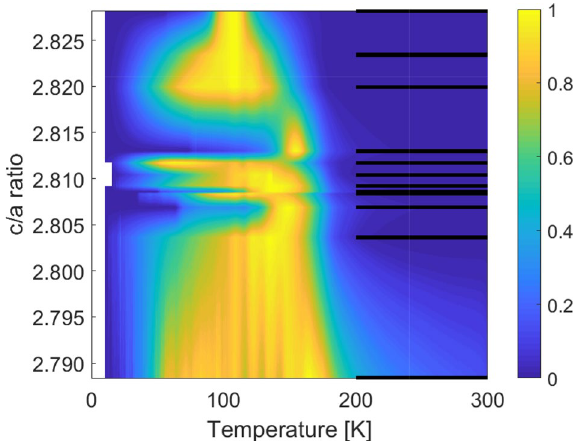
Figure 8. Combined plot revealing the temperature of the transition from all the samples investigated in the study highlighting the hysteresis in the resistance of the films with temperature. The colourscale shows the normalized difference of the logarithm of the resistance, ( log 10 ( R heating ) − log 10 ( R cooling ) ) divided by the maximum difference for each measurement, as a function of temperature. The black lines show the determined c / a values for the